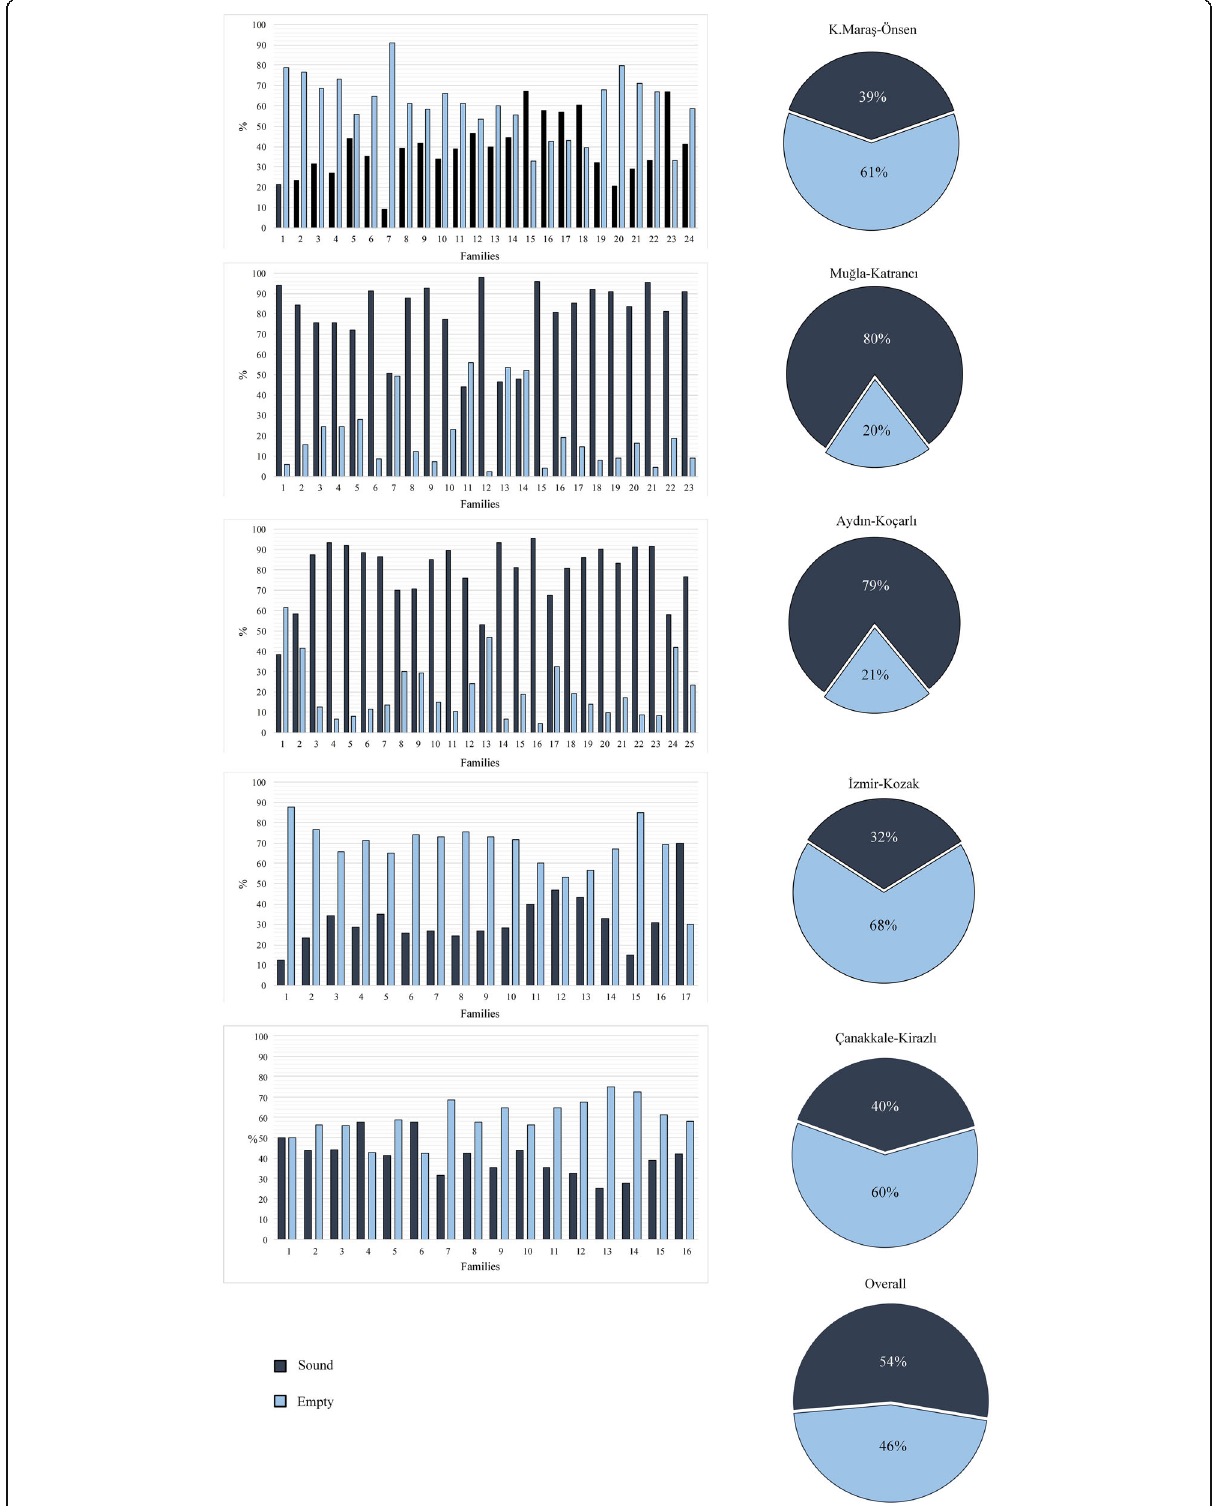
Fig. 2 Percentages of sound versus empty seeds among, and between, the five natural populations of P . pinea across